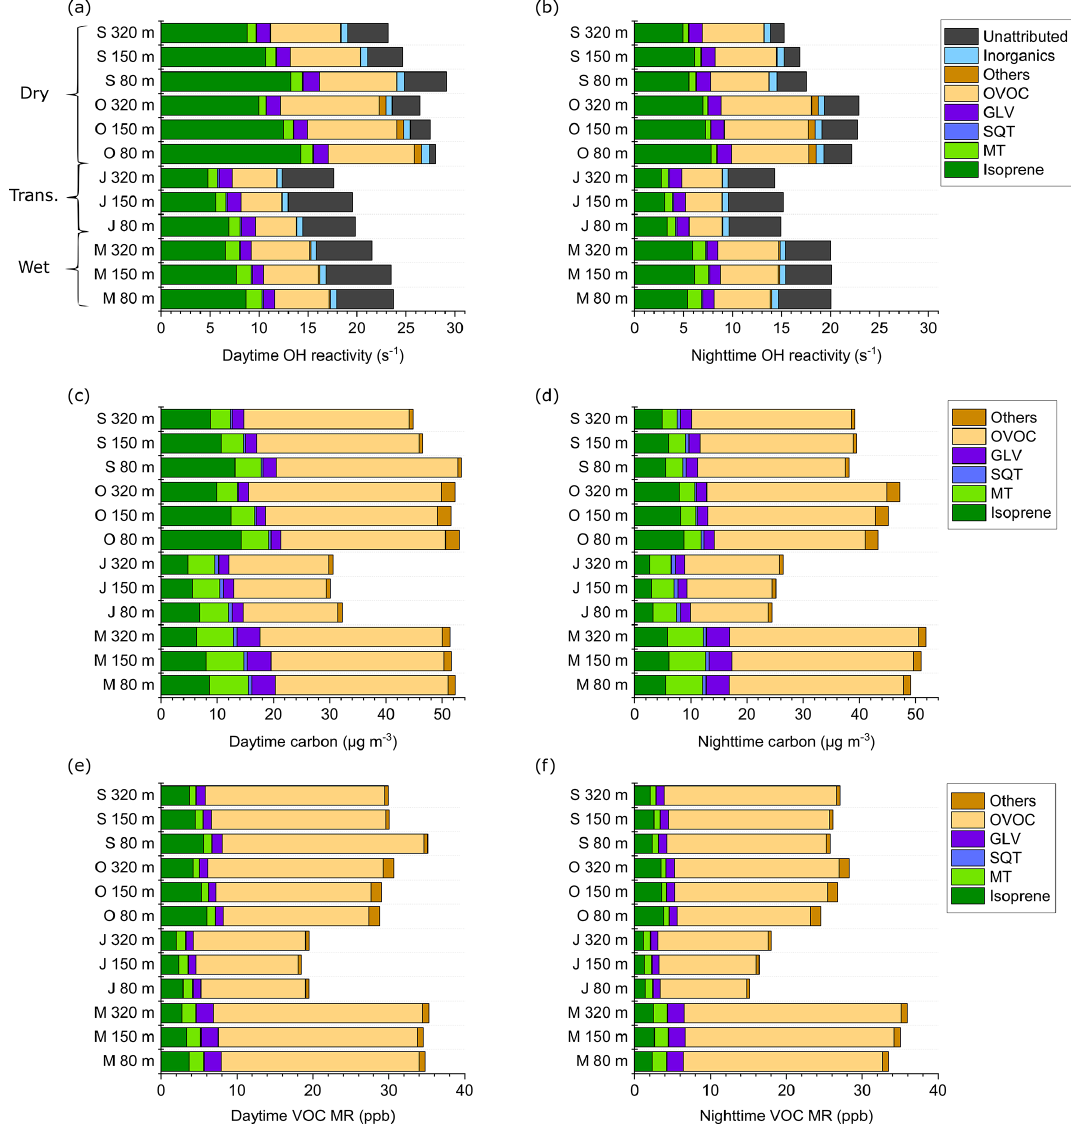
Figure 5. (a) Average total OH reactivity and speciation at the ATTO tall tower by season and height a.g.l., daytime. (b) Same as (a) , nighttime. (c) VOC carbon concentration by compound class by season and height, daytime. (d) Same as (c) , nighttime. (e) Summed VOC mixing ratio (MR) by compound class, season, and height, daytime. (f) Same as (e) , nighttime. The individual compounds included in each class are listed in Table S1. Daytime was defined as PAR > 0 and nighttime as PAR = 0. S: September 2019; O: October 2018; J: June 2019; M: March